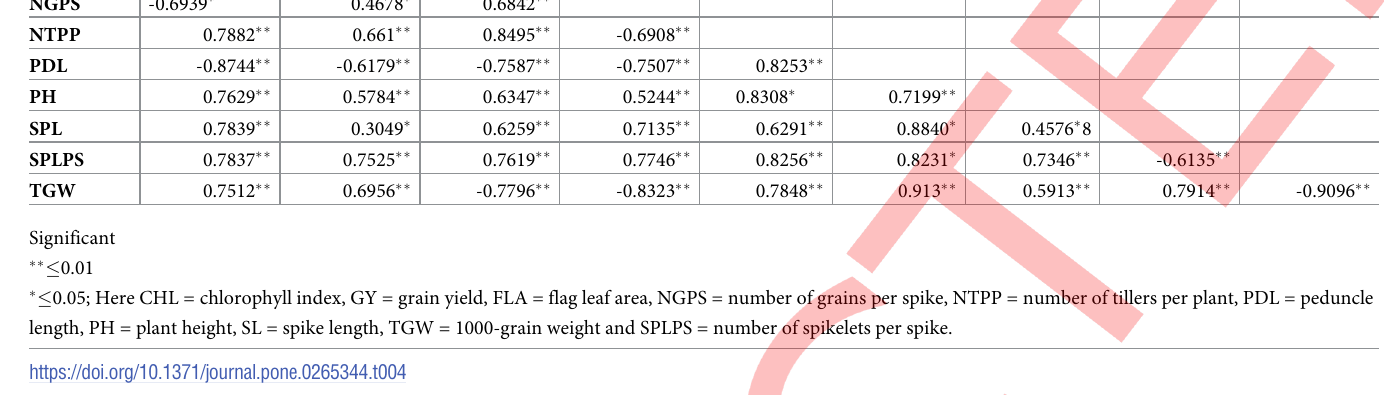
indicate that ‘Line 9733’, ‘Bhakar-2002’, ‘Line A9’ and ‘SYN-46’ are better tolerated to study area compared to the rest of the genotypes included in the study. The results of the current study revealed that peduncle length was positively correlated with spike length, flag leaf length, number of grains per spike, 1000-grain weight, and grain yield (Table 4). Grain yield had positive correlations with flag leaf area, plant height, spike length, number of grains per spikes and 1000-grain weight. Principal component analysis conducted on the growth and yield related traits of the wheat genotypes included in the study yielded only one principal component with eigenvalue > 1 (Table 5). The first principal component explained 85.70% variability in the data, and it was positively influenced by all of the growth and yield-related traits. Biplot obtained from the